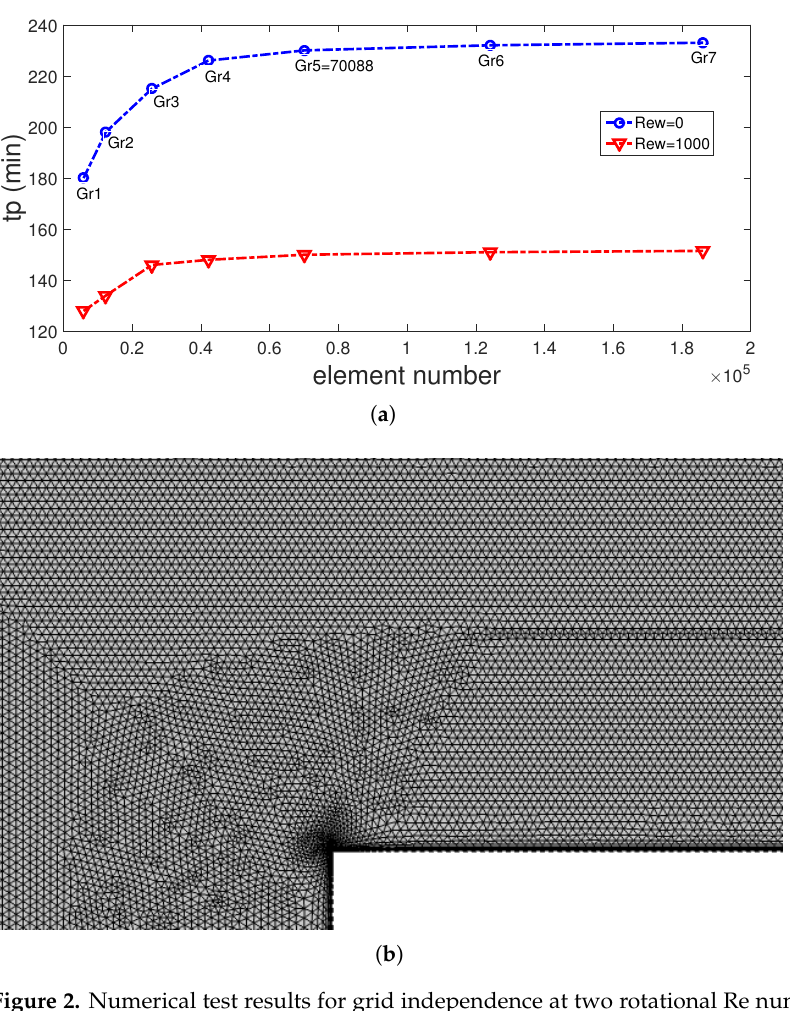
Figure 2. Numerical test results for grid independence at two rotational Re numbers ( a ) and grid distribution for one part of the computational domain ( b ).